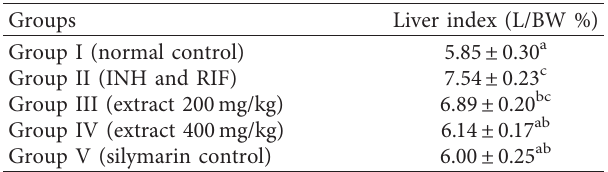
Table 3: Liver index in different experimental groups of